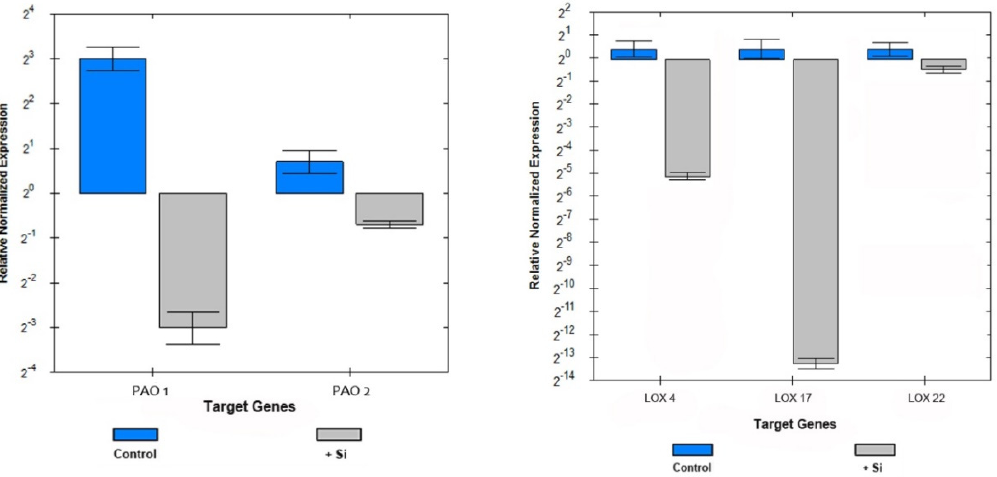
Figure 6. RT-qPCR data for transcript abundance of the PAO1 , 2 and LOX 4, 17, 22 genes in control and silicon-treated leaf samples.